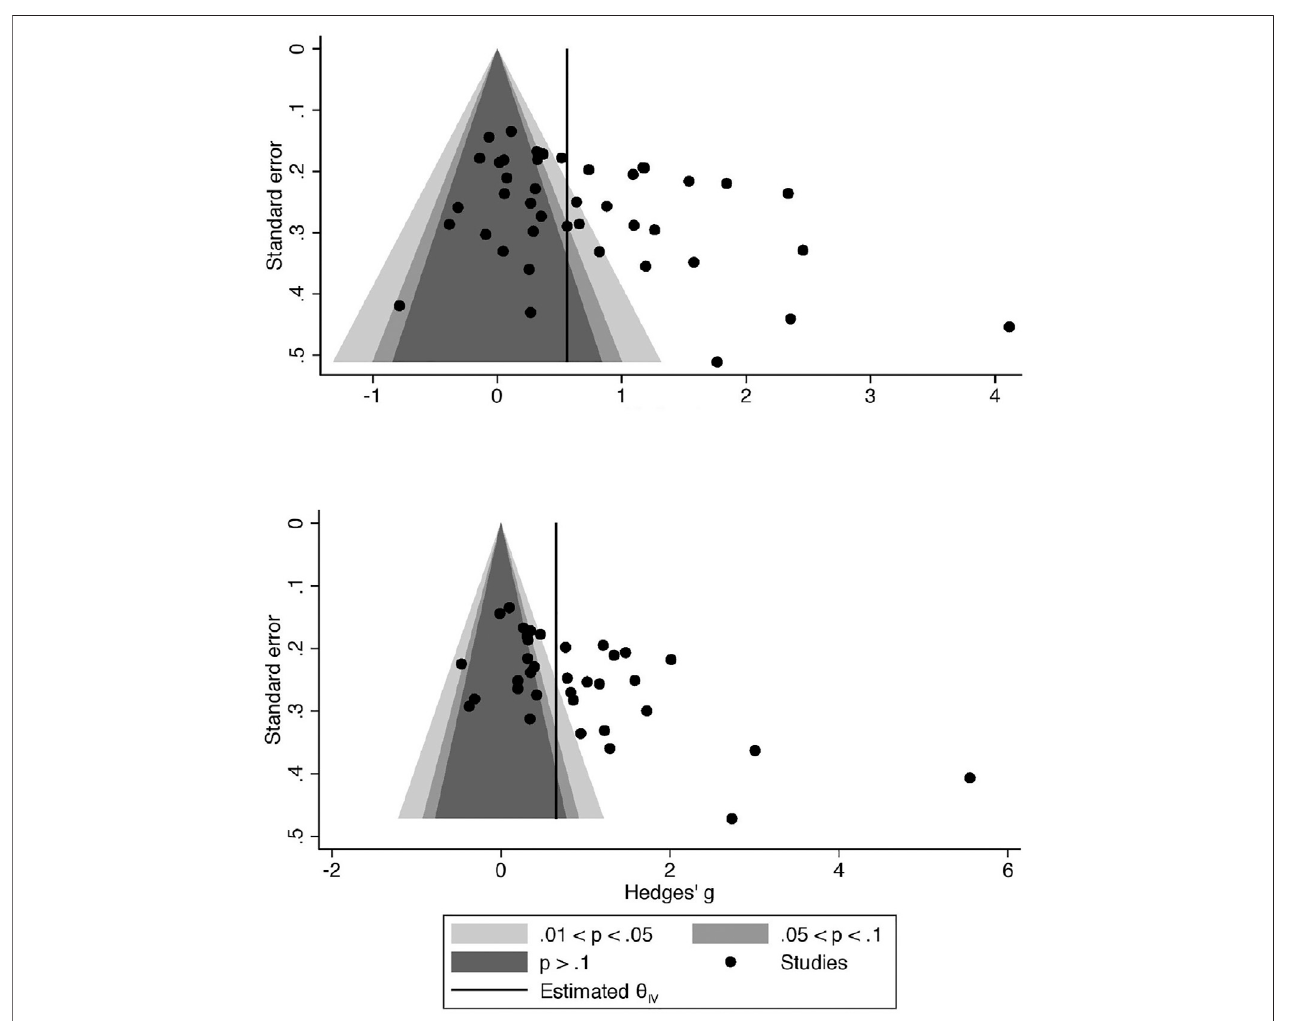
FIGURE 8 | Contour-enhanced funnel plots for studies reporting pain (A) and anxiety (B) outcomes.